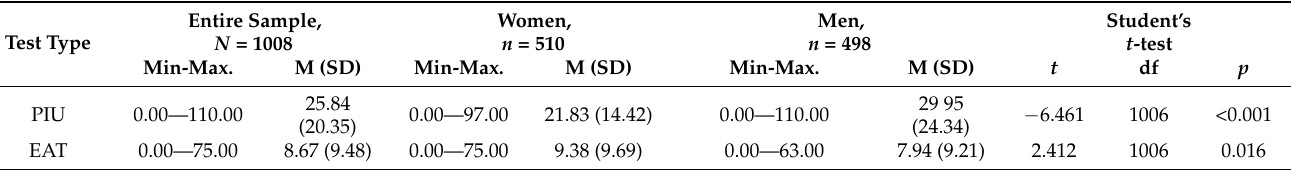
Table 2. PIU and EAT-26 scores in the entire sample, with male and female